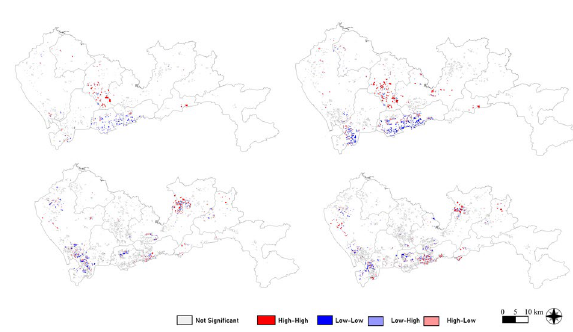
Figure 10. Lisa significance of mismatch degree of living